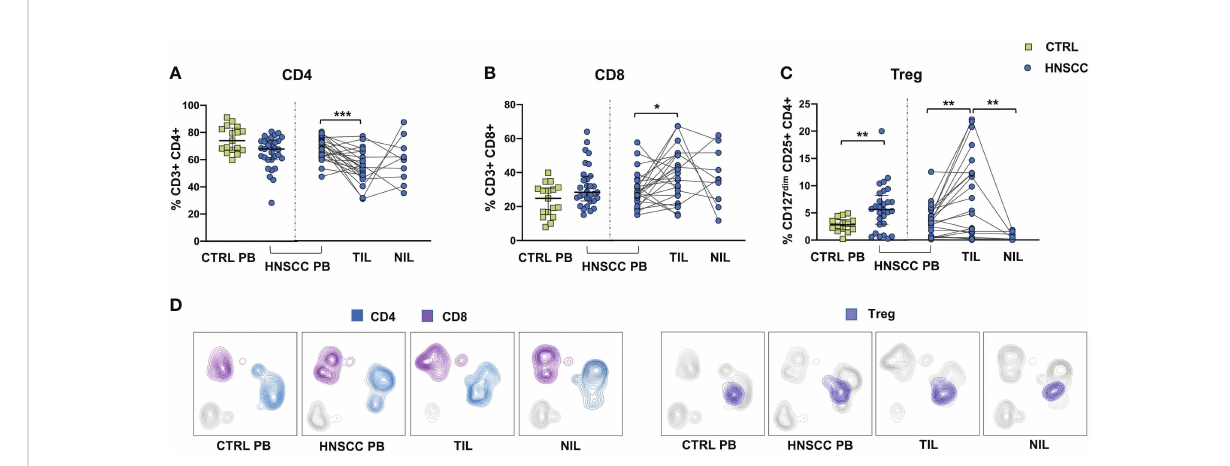
FIGURE 6 (A) Frequencies of CD4+ T cells, (B) CD8+ T cells, (C) Treg cells in PBMC from healthy donors (CTRL PB) and HNSCC patients (HNSCC-PB) and in matched tumor-in fi ltrating (TIL) and surrounding non-tumor-in fi ltrating lymphocytes (NIL). The Mann – Whitney U test was used to compare CTRL and HNSCC subjects. Paired data were analyzed by the Wilcoxon signed rank test. *p < 0.05, **p < 0.01, ***p < 0.001. (D) UMAP (Uniform Manifold Approximation and Projection for Dimension Reduction) representation of manually gated CD4, CD8 and Treg cells.